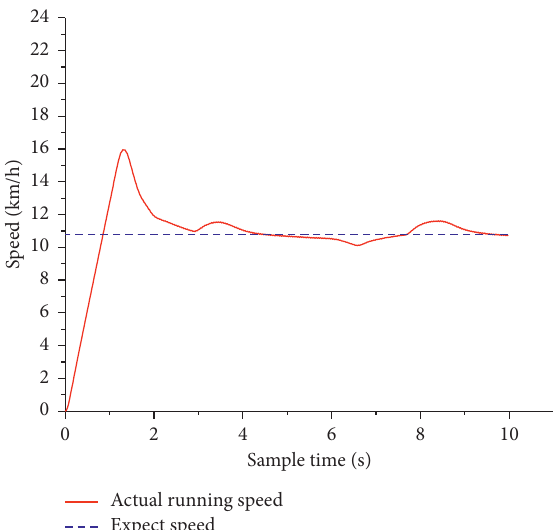
Figure 11: Path position tracking simulation